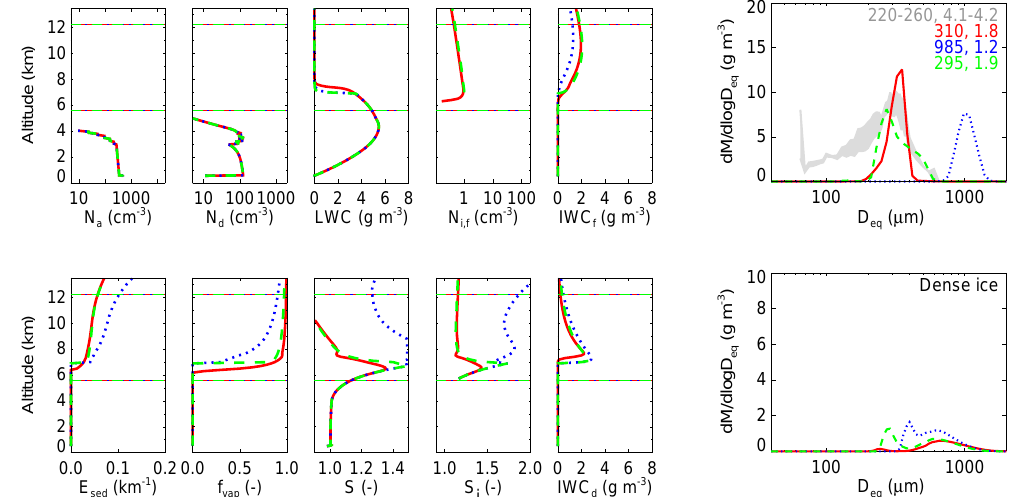
Figure 13. Panels and processes as in Fig. 10 for baseline updraft, with pseudo-Hallett–Mossop source of 2stdcm − 3 (red solid line), and without pseudo-Hallett–Mossop source but with 1stdcm − 3 of immersion-mode IFN and freezing-induced drop shattering with net multiplication factors of 5 (blue dotted line) and 50 (green dashed line). Details provided in